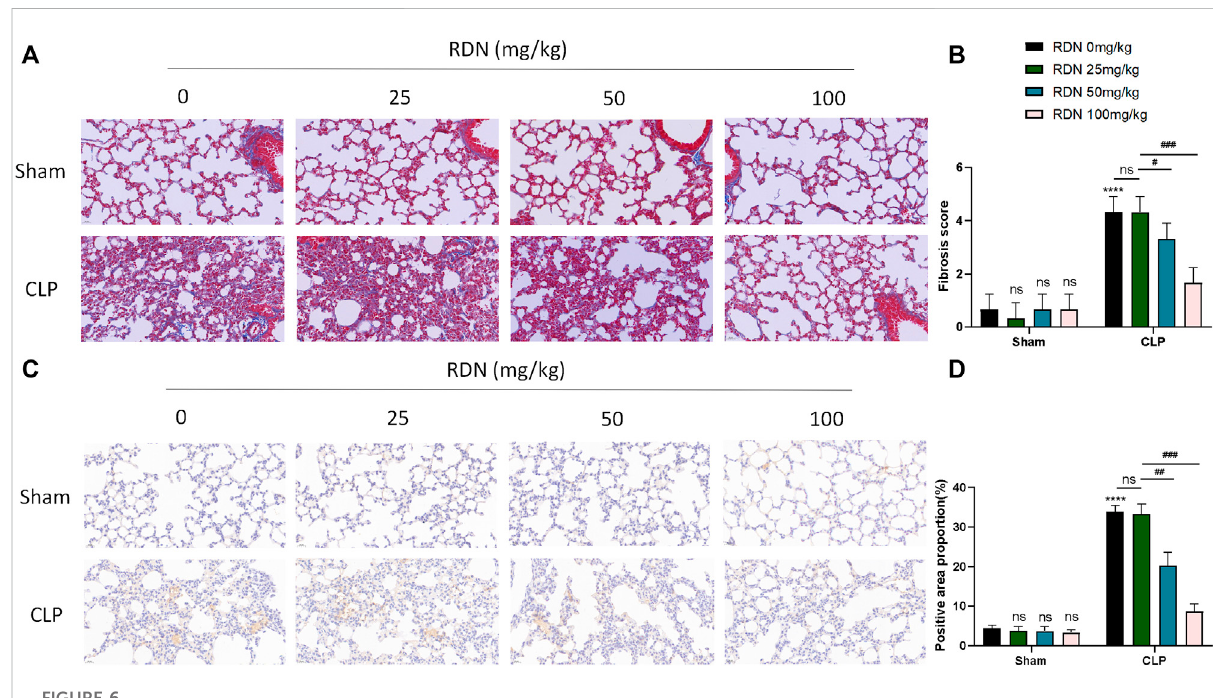
FIGURE 6 Expression level of fi brosis in mouse lung tissue 21 days after CLP operation. (A,B) Masson staining of mouse lung tissue. (C,D) IHC staining of mouse lung with α -SMA. Data arepresented as mean ± SD(n = 3per group) of therepresentativedata from three independent experiments; **** p < 0.001, ### p < 0.005, ## p < 0.01, and # p < 0.05. The asterisk (*) represents statistically signi fi cant difference between the indicated group and the Con